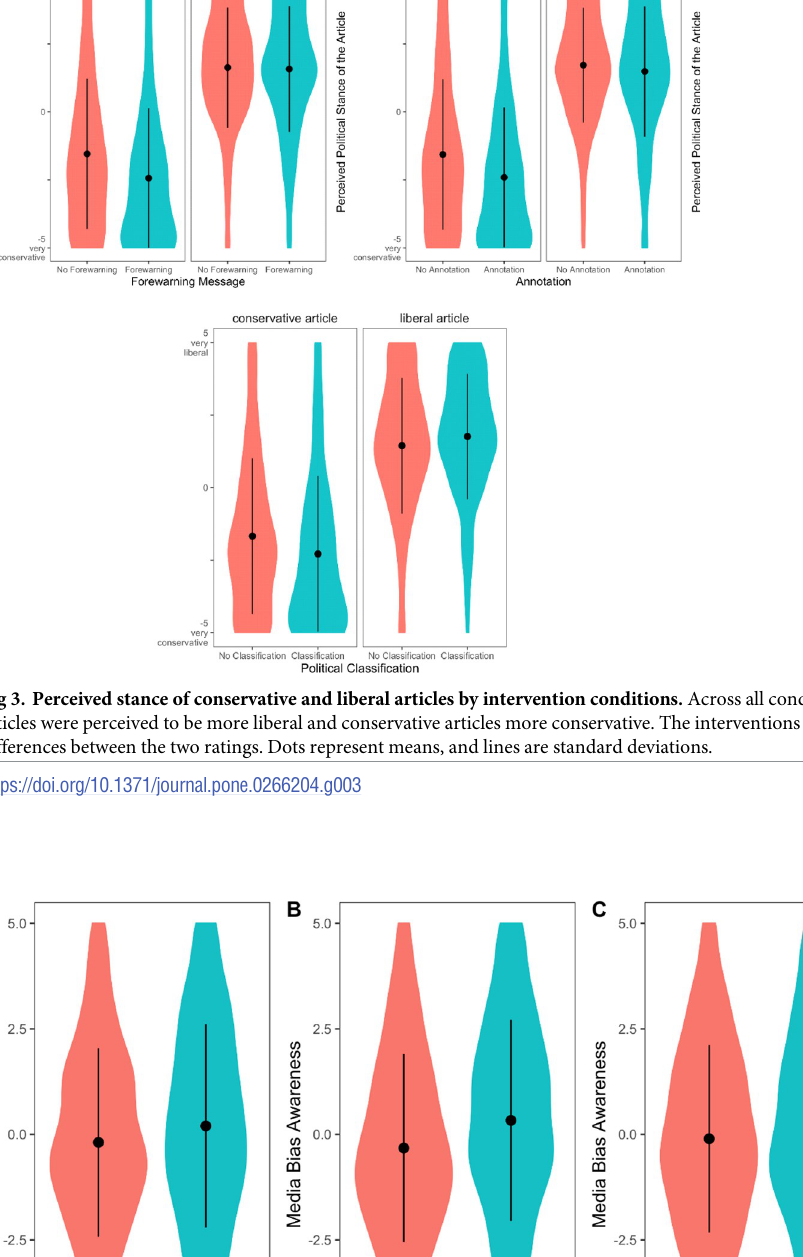
PLOS ONE | https://doi.org/10.1371/journal.pone.0266204 April 13,